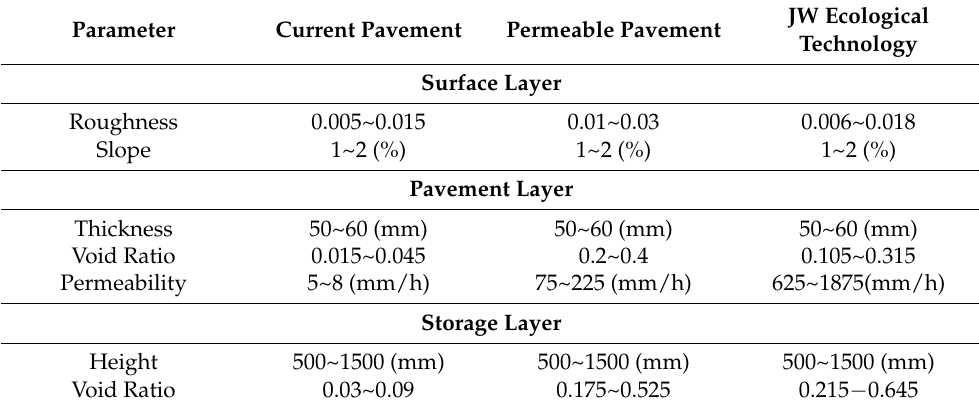
Table 2. The value range of permeable pavement parameter of the stormwater management model.